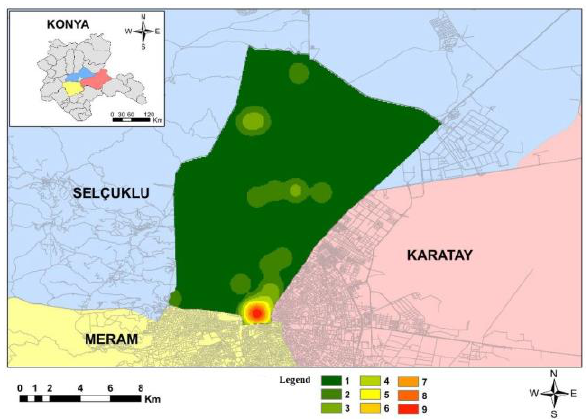
Figure 11. Existing parking areas density analysis